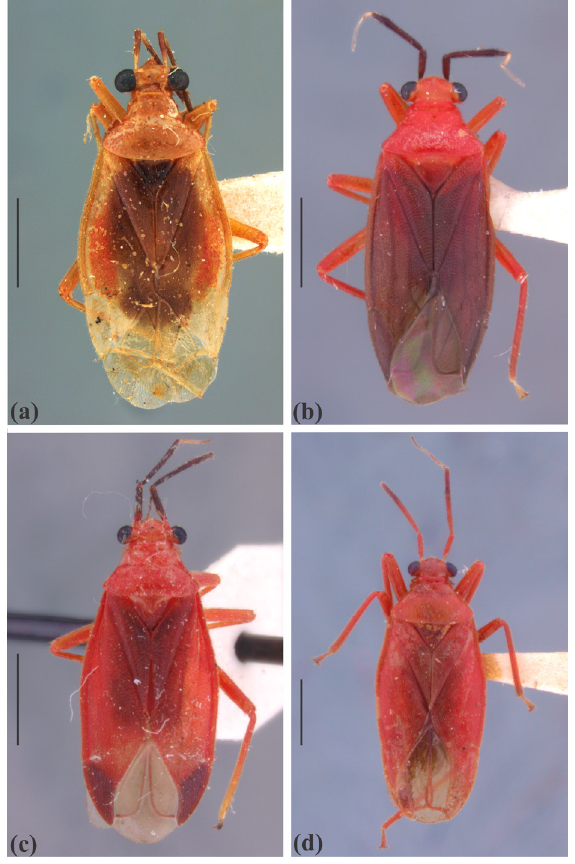
Figure 4. Dorsal view. (a) Adneella nigronotata (Carvalho 1954), male; (b) Neella eucosma (Stål 1862) Reuter 1908 , female ; (c) Neoneella zikani Costa Lima 1942 , female ; (d) Proneella boliviana Carvalho 1960 , male . Scale : 1.5 mm.